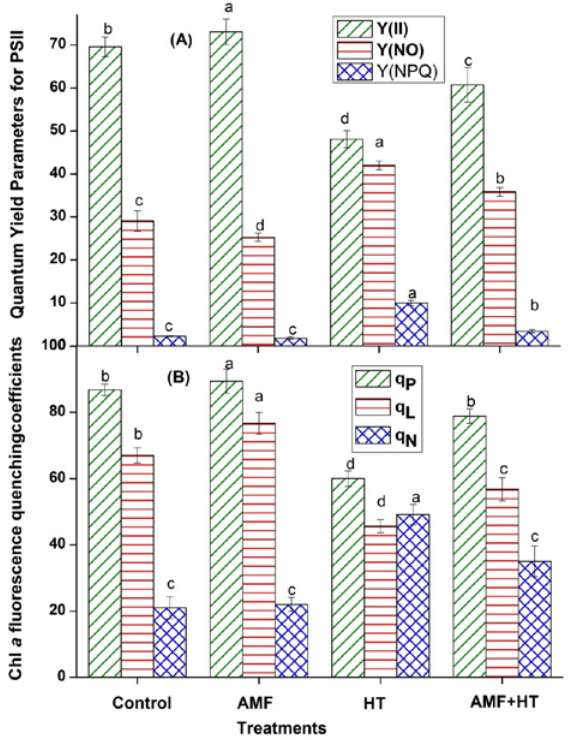
Figure 1. Quantum yields of energy conversion in PSII in control, AMF, high temperature (HT), AMF + HT for ( A ) Y(II) = quantum yield of PSII, Y(NO) = the yield of non-regulated energy dissipation, Y(NPQ) = the yield of regulated energy dissipation, ( B ) Chlorophyll fluorescence quenching coefficients (q P , q L , q N ) in maize leaves under high temperature. The data are the mean values of three replicates ± standard deviation, treatment means followed with different letters vary significantly at p = 0.05 in compliance with Fisher least significant differences (LSD) and Duncan multiple range test (DMRT) for multiple comparisons.